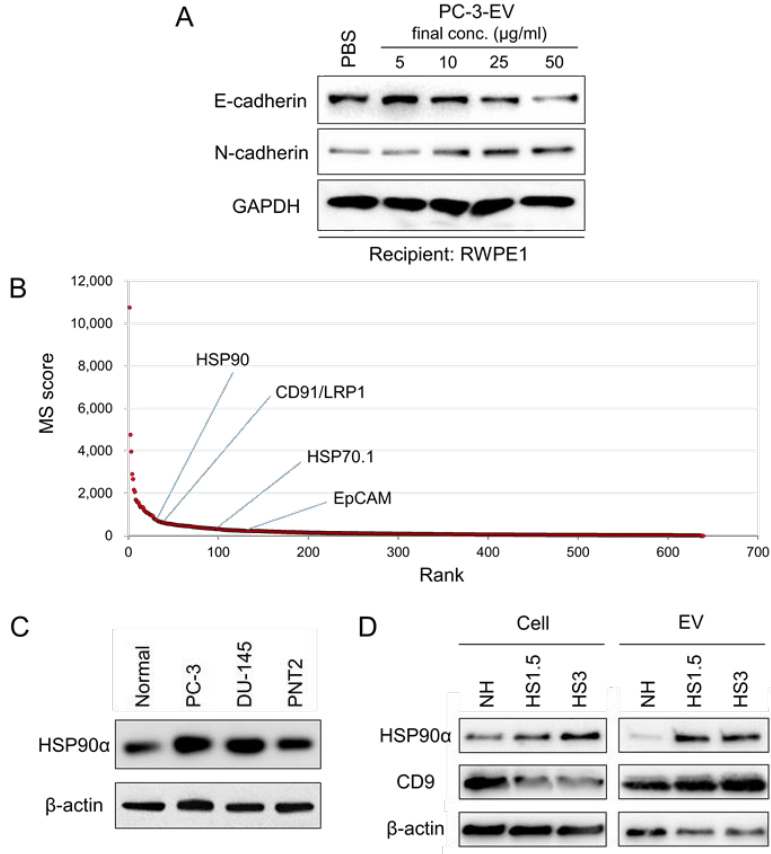
Figure 1. The pro-epithelial-to-mesenchymal transition (EMT) effect, proteome, and stress response of extracellular vesicles (EVs) released by PC-3 cells. ( A ) Western blot showing E-cadherin / CDH1, N-cadherin / CDH2, andGAPDH.EVswerepreparedusing200-nmporefilterdevicesandpolymer-based precipitation(PBP)methodfromculturemediaofPC-3. RWPE-1cellsweretreatedwiththePC-3-derived EV at 5, 10, 25, or 50 µ g / mL or PBS for 3 days and then lysed. ( B ) Scores of proteins identified by LC-MS / MS. ( C ) Western blot showing heat shock protein (HSP)90 α and β -actin expressed in normal prostate epithelial cells, PC-3, DU-145, and PNT2 cells. The same set of protein samples was used previously [60]. ( D ) Western blot showing HSP90 α , CD9, and β -actin in EVs and cells. PC-3 cells were stimulated with heat shock stress (HSS) for 1.5 or 3 h or non-heated (NH) and then cultured in serum-free media for 24 h to collect EVs and cell